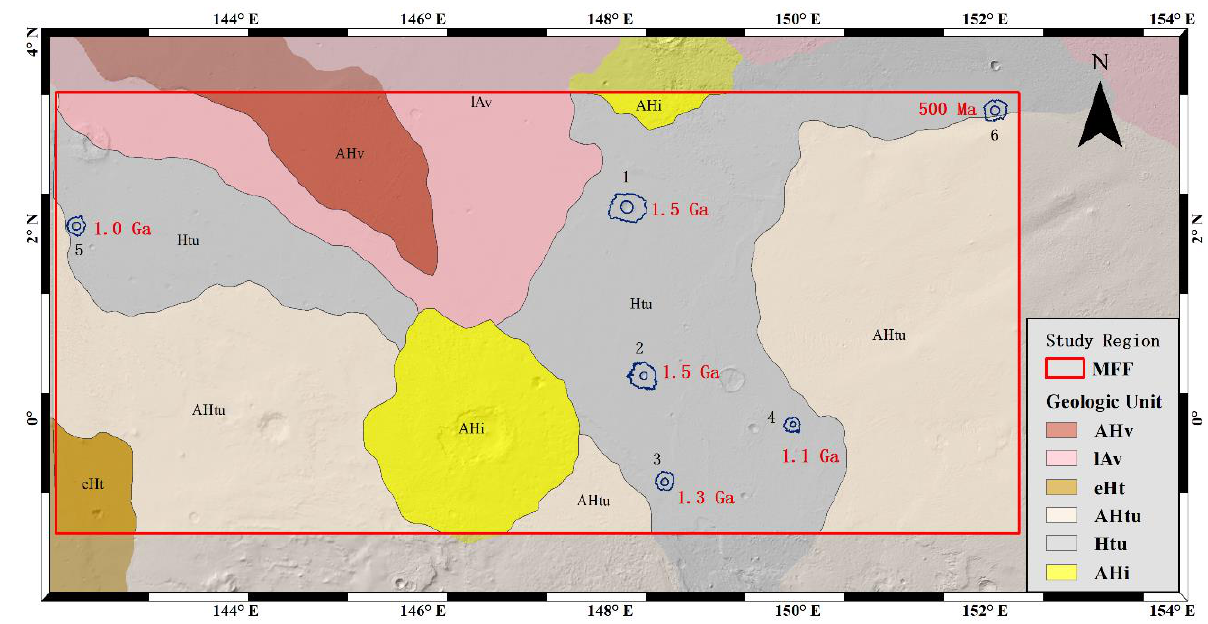
Figure 5. Distribution of layered ejecta craters and the absolute model age (AMA). The base map is the geological map [11] overlaid on the Mars Orbiter Laser Altimeter (MOLA) hillshade relief map. The red rectangle is about 607 m from east to west and 273 m from north to south.